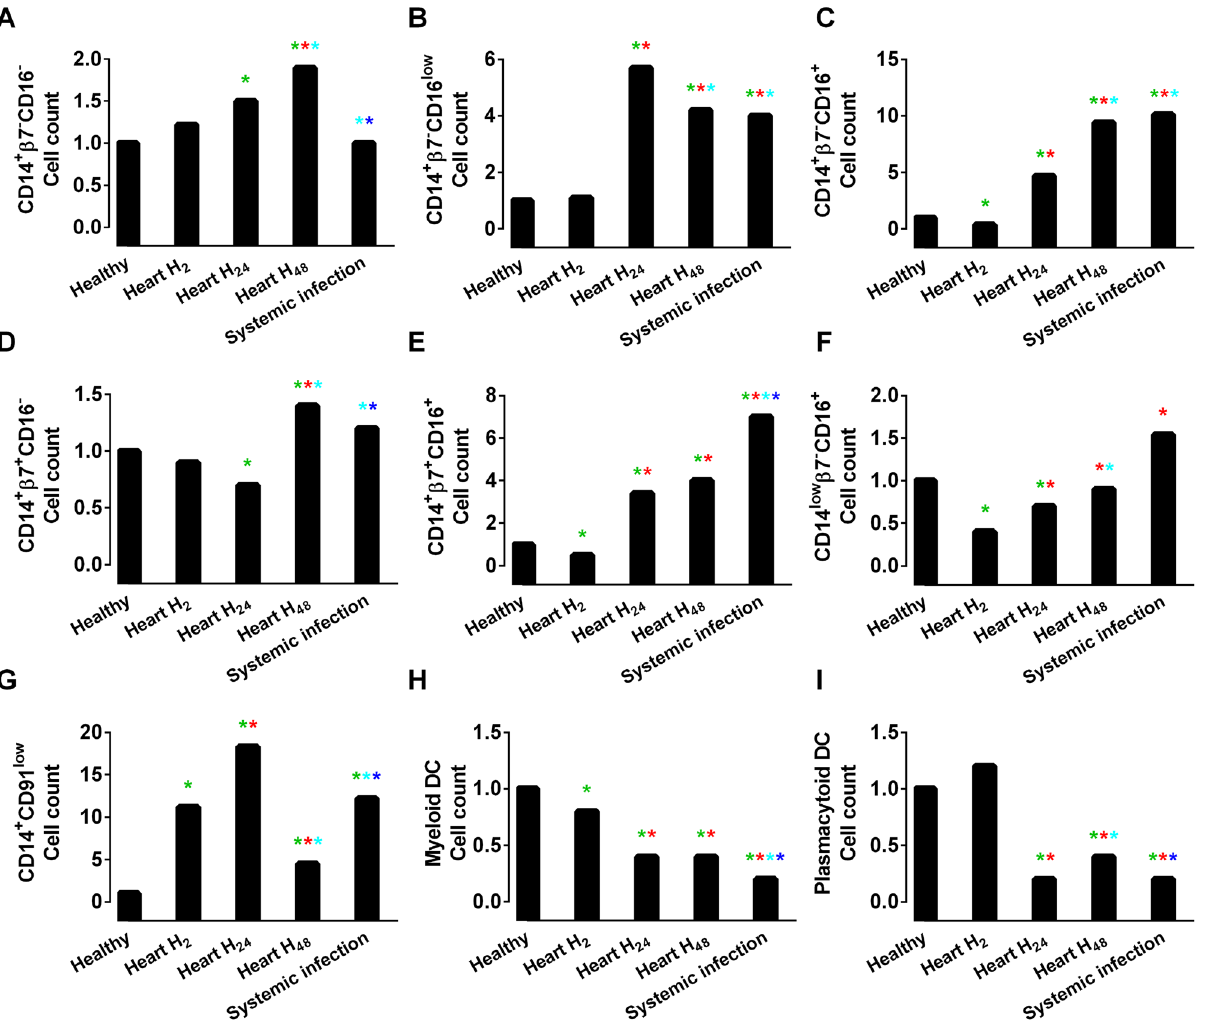
Figure 2. Monocyte and dendritic cell counts for CD14 + β7 - CD16 - monocytes ( A ), CD14 + β7 - CD16 low monocytes ( B ), CD14 + β7 - CD16 + monocytes ( C ), CD14 + β7 + CD16 - monocytes ( D ), CD14 + β7 + CD16 + monocytes ( E ), CD14 low β7 - CD16 + monocytes ( F ), CD14 + CD91 low monocytes ( G ), myeloid dendritic cells ( H ) and plasmacytoid dendritic cells ( I ). The data are presented as the mean ± standard error of the mean (SEM) in healthy, cardiac surgery patients at 2 (H 2 ), 24 (H 24 ), 48 (H 48 ) hours and systemically infected patients. The data scale was normalized to reflect the relative increase or decrease compared to healthy subjects. P < 0.05 vs. Healthy “green asterisk” vs. Heart H 2 “red asterisk”; vs. Heart H 24 “light blue asterisk”; vs. Heart H 48 “dark blue